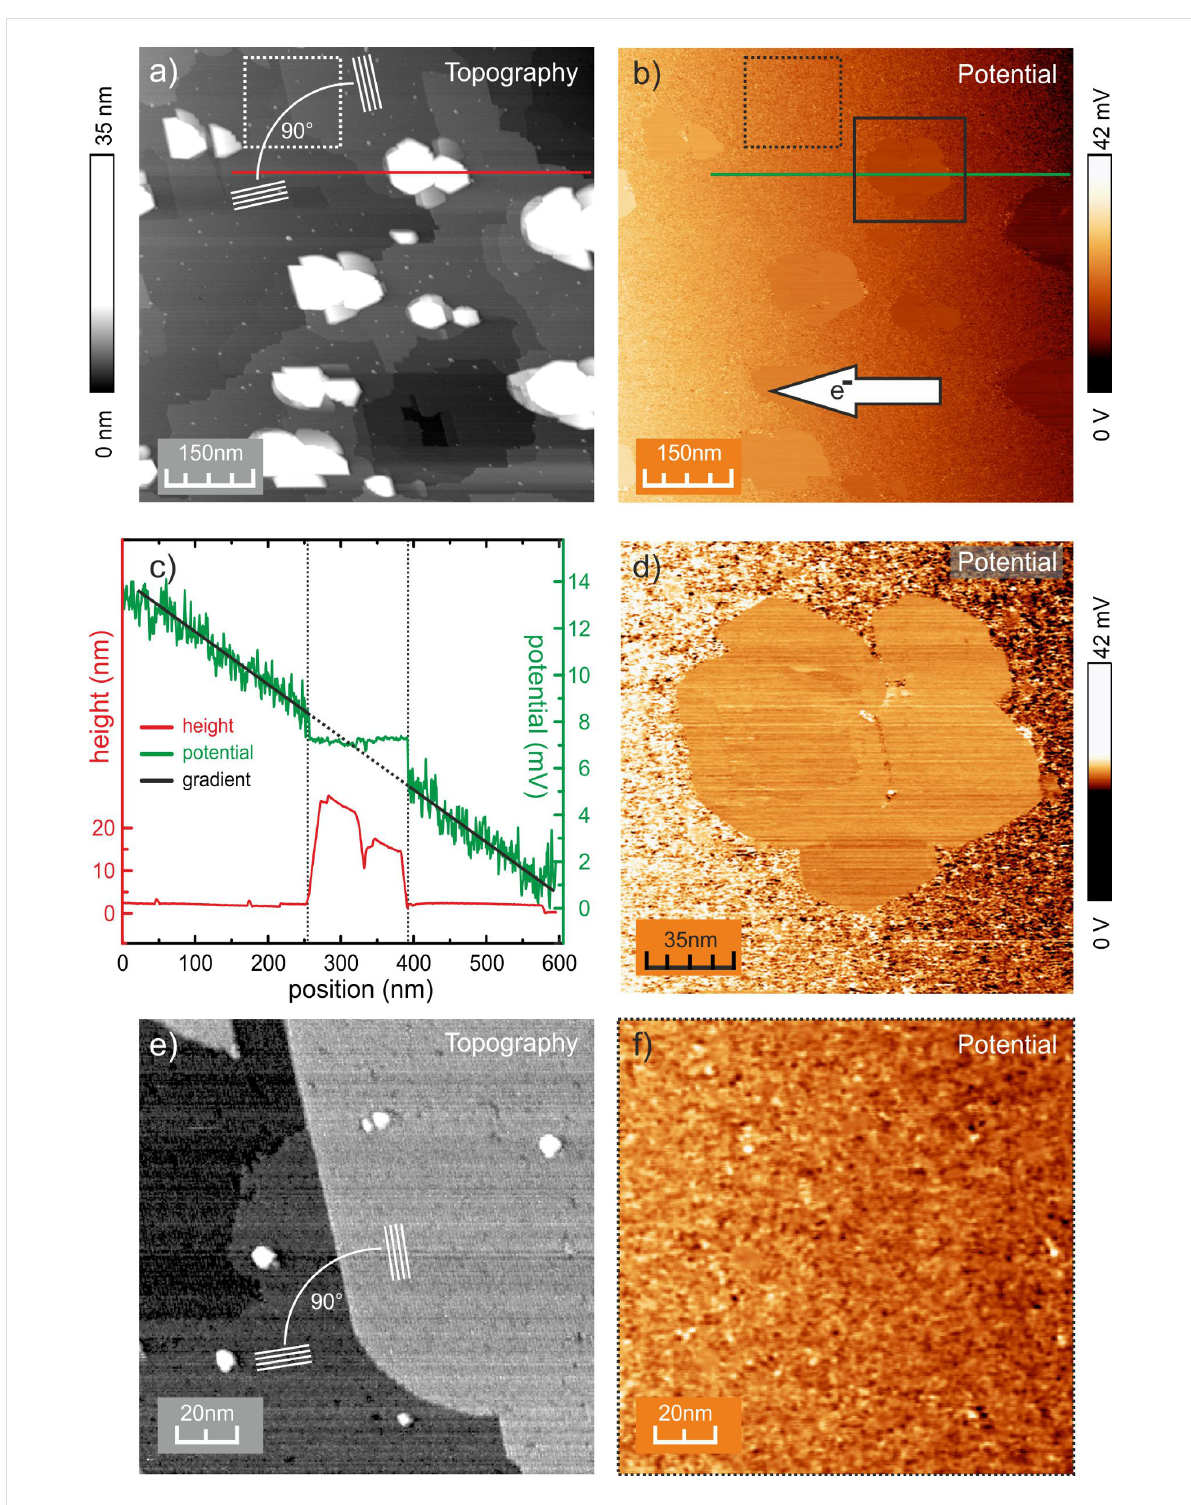
Figure 2: a) STM image of the Au/Ge(001) surface showing both different types of Au wire-like domains and several Au clusters. b) Corresponding image of the potential, exhibiting a constant gradient on the terraces (Au wire-like domains). The Au clusters appear with constant potential and rather sharp transitions at their borders. c) Line profiles of the topography (red) and potential (green) as marked in a) and b). As a guide to the eye a linear function was fitted to the overall gradient of the potential. d) Potential near a Au cluster. Sharp transitions of the potential at the perimeter of the cluster are easily recognized. e) and f) show the topography and the corresponding potential for a small area near a step edge, i.e., domain boundary. The directions of the atomic wires are marked by white lines in a) and e) ( V bat = 9 V, I trans = 3